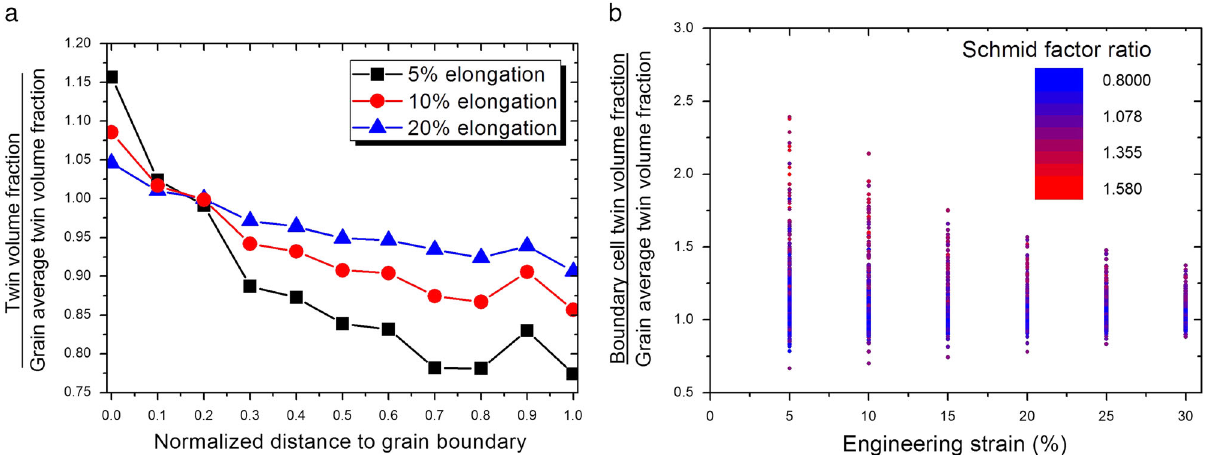
Fig. 5 Change in twinning behavior upon deformation: a Twin volume fraction normalized by grain average twin volume fraction plotted against normalized distance to grain boundary after 5% ( black ), 10% ( red ), and 20% ( blue ) elongations; b Twin volume fraction of grain boundary region normalized by its respective grain average twin volume fraction during tensile deformation up to 30% color coded by the Schmid factor ratio of each grain